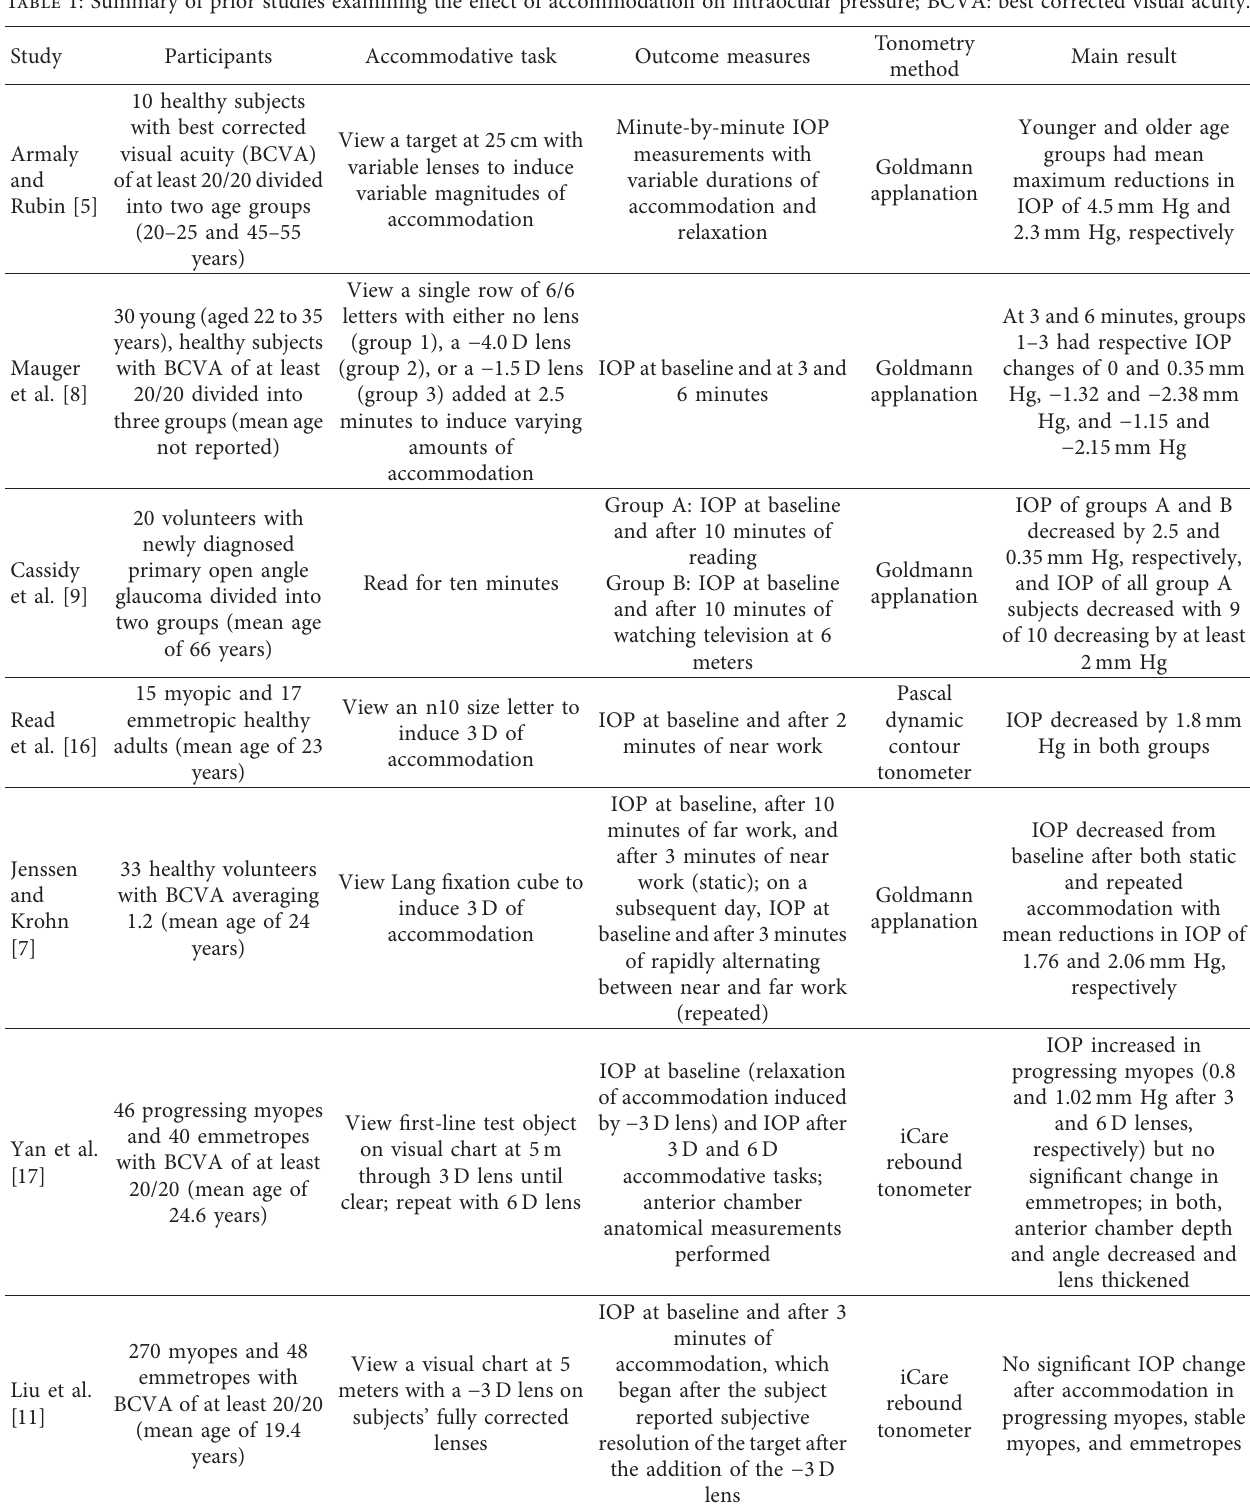
Table 1: Summary of prior studies examining the effect of accommodation on intraocular pressure; BCVA: best corrected visual acuity.